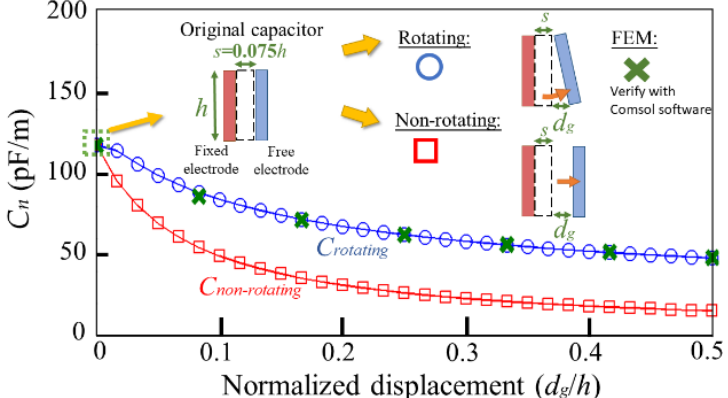
Figure 5. Capacitance per unit length versus normalized displacement for the rotating and non-rotating electrodes.